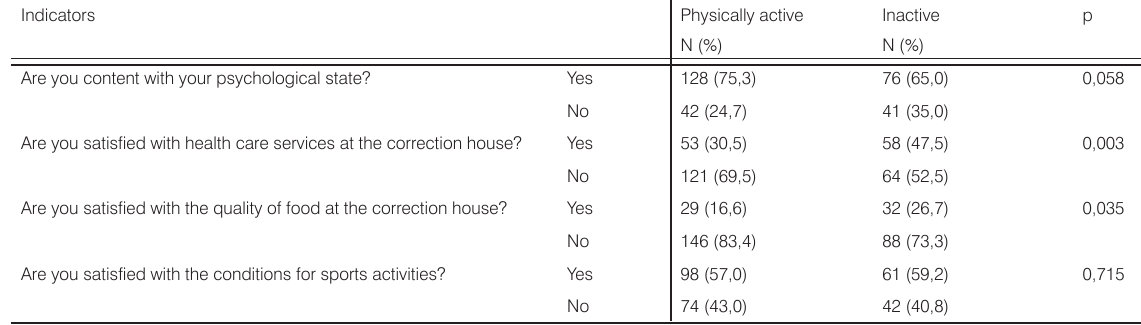
Table 2. Distribution of physically active and inactive respondents according to the future perspectives.